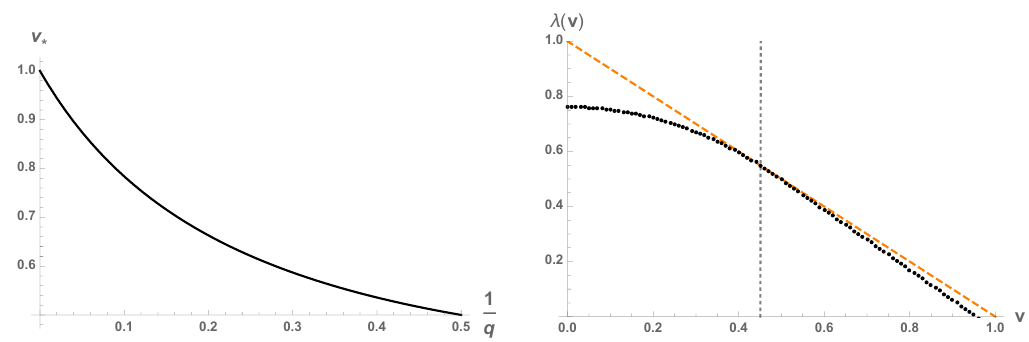
Figure 7 . Left: critical velocity v in the bosonic MSW model. Right: the black dots are the (cid:3) saddle point contribution to the VDLE, the orange, dashed line is the contribution of the pole at 1 = 0 : 75. (In order to see de(cid:12)nite deviation between p = i , for the bosonic MSW model and q (cid:0) the black dots and the orange line, we use an unphysical value of q in this (cid:12)gure.) They exchange dominance at the critical velocity, drawn gray, dotted. Virtually identical plots can be produced for the SUSY version of the model.